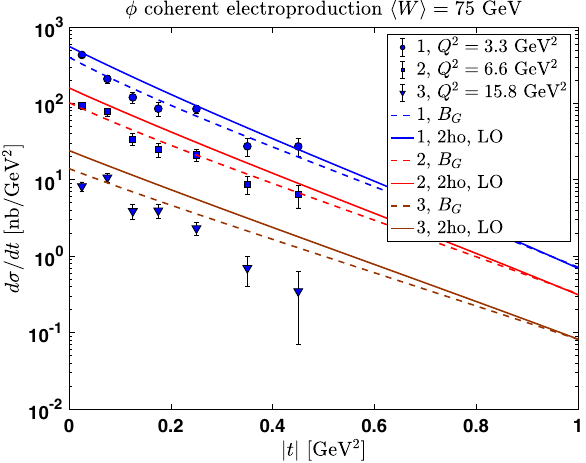
Fig. 14 Differential cross sections for coherent electroproduction of φ mesons as a function of the total momentum transfer (square) t . The data refer to the HERA H1experiment [40] and are compared with present calculations within the QMBA (2 h.o.) and the Gaussian ( B G ) approximation profiles